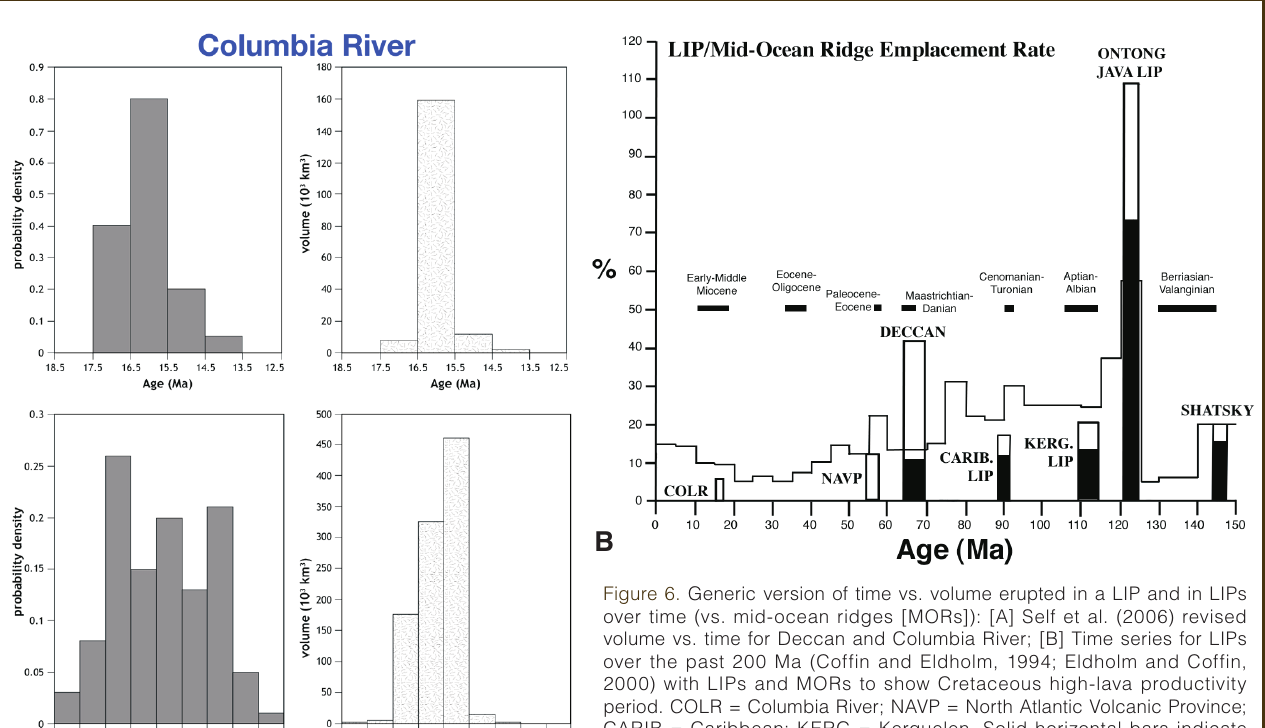
Figure 6. Generic version of time vs. volume erupted in a LIP and in LIPs over time (vs. mid-ocean ridges [MORs]): [A] Self et al. (2006) revised volume vs. time for Deccan and Columbia River; [B] Time series for LIPs over the past 200 Ma (Coffin and Eldholm, 1994; Eldholm and Coffin, 2000) with LIPs and MORs to show Cretaceous high-lava productivity period. COLR = Columbia River; NAVP = North Atlantic Volcanic Province; CARIB = Caribbean; KERG = Kerguelen. Solid horizontal bars indicate Cenozoic and Cretaceous mass and other extinction events (after Rampino and Stothers, 1988; Thomas, 1992).